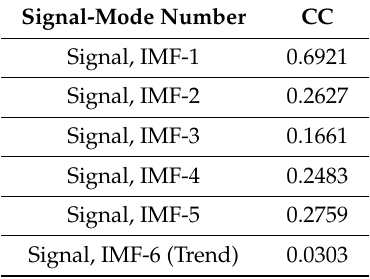
Figure 7. The EMD of the DMI signal in the North Indian Ocean is illustrated in the adjoining figure. The signal here is derived using the Dataset-2. The DMI signal is shown in the first panel and its trend in the seventh panel. The intrinsic modes of the signal are presented in between these two panels. The retained mode considered for further analysis is shown in a bold line (IMF 3). Table 6. Correlation Coefficient (CC) values of the DMI modes and the signal derived from Dataset- 2.